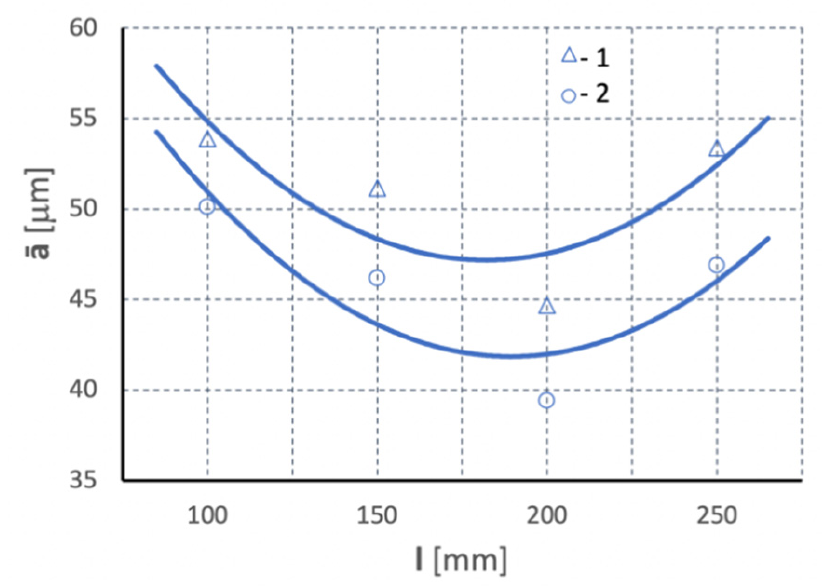
Figure 6. The average particle size of comminuted hard coal ( a ) in the function of the length (l) of the homogenizing nozzle without the thread-groove opening (1) and with the thread-groove opening d h = 4.5 mm (2).